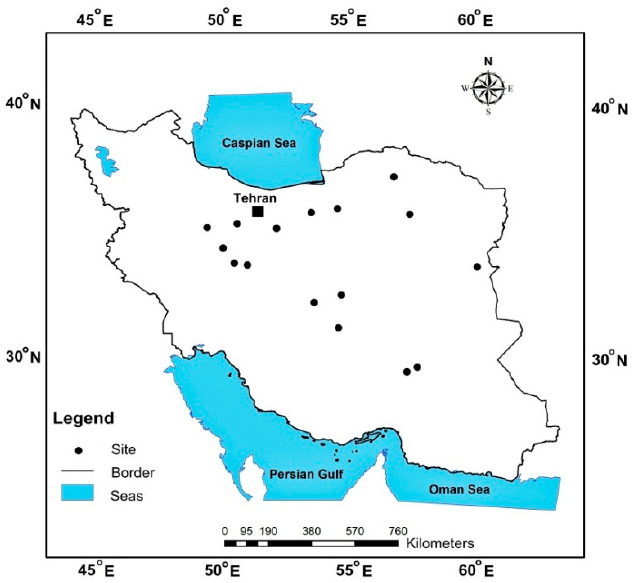
Figure 1. Location of studied sites in Iran.